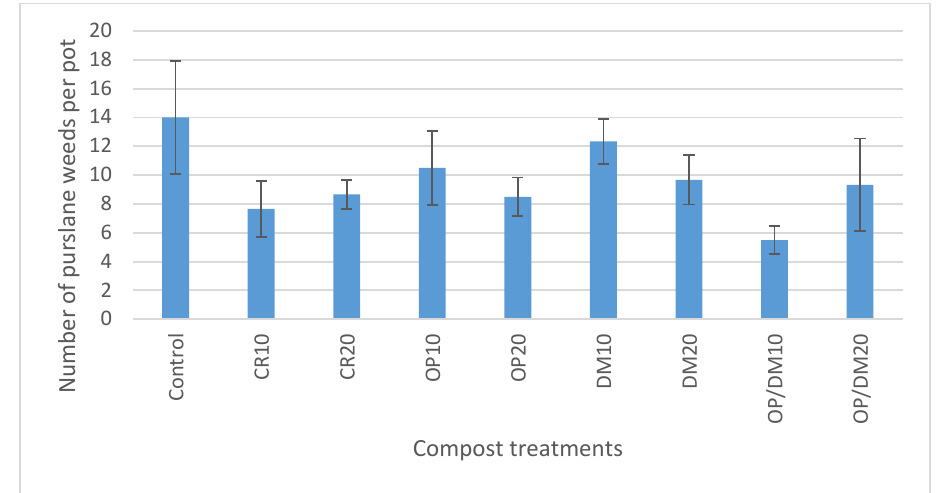
Figure 6. Number of purslane weeds per pot as affected by different compost sources and rates. Error bars represent ± standard error ( P = 0.293, n = 6).